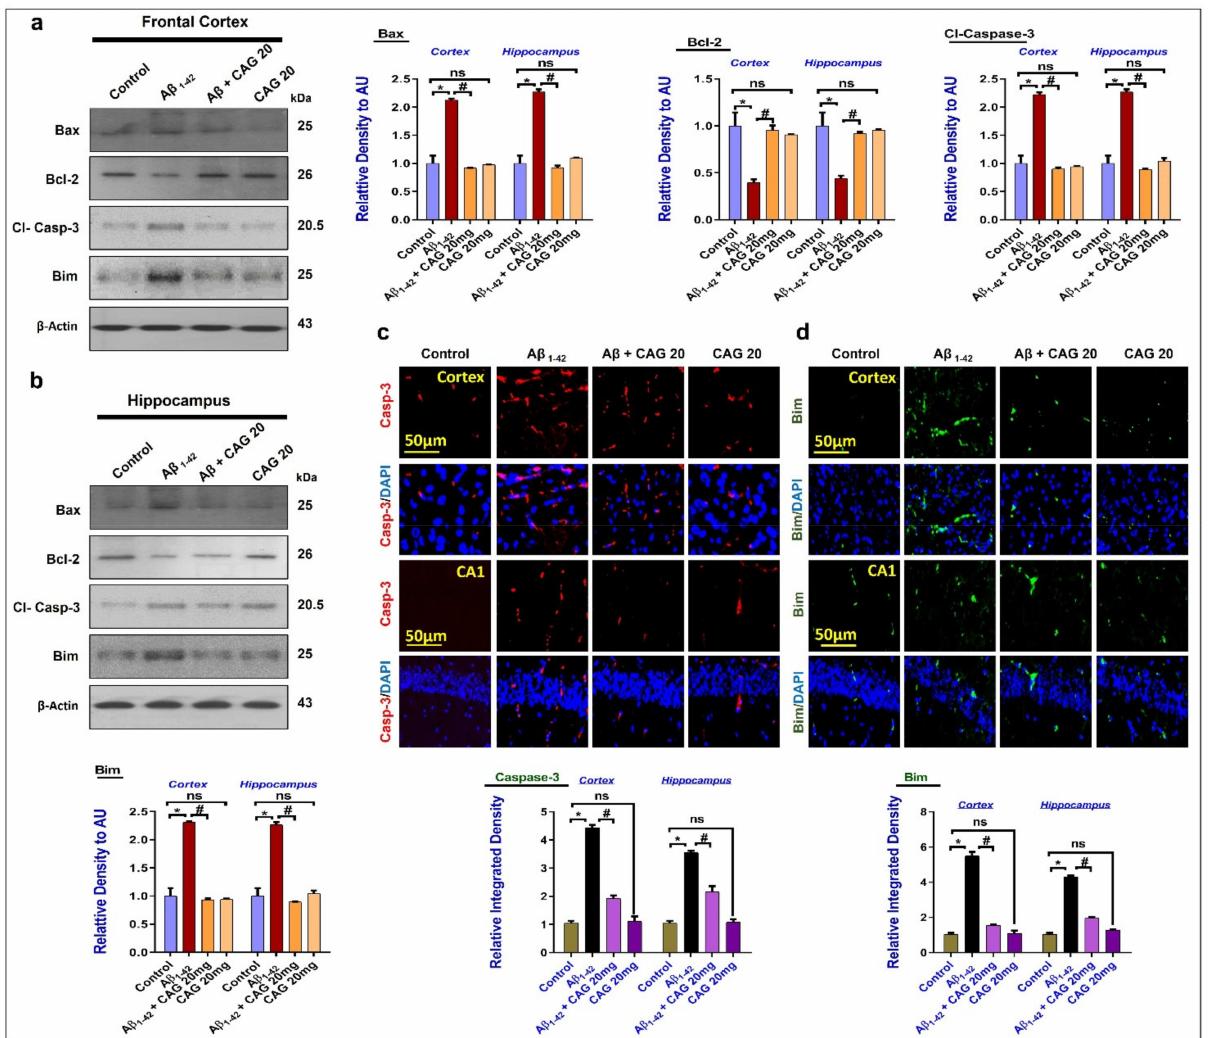
Figure 4. Effects of cycloastragenol against the mitochondrial dysfunction in an A β -induced mouse model of Alzheimer’s disease. ( a , b ) Western blot results of Bax, Bcl-2, cleaved Caspase-3, and Bim in the experimental mice’s brains, with respective bar graphs. ( c , d ) Immunofluorescence analysis of Caspase-3 and Bim in the cortex and hippocampus of experimental mice, with respective bar graphs. The p -value < 0.05 was considered a significant difference. * showing a significantly different from the control group; # significantly different from the A β -injected group. Significance = * p < 0.05; # p < 0.05. CAG 20: Cycloastragenol 20 mg/Kg, A β : Amyloid beta, DAPI: 4 (cid:48) ,6-Diamidino-2-phenylindole, CAG: Cycloastragenol, ns: non-significant